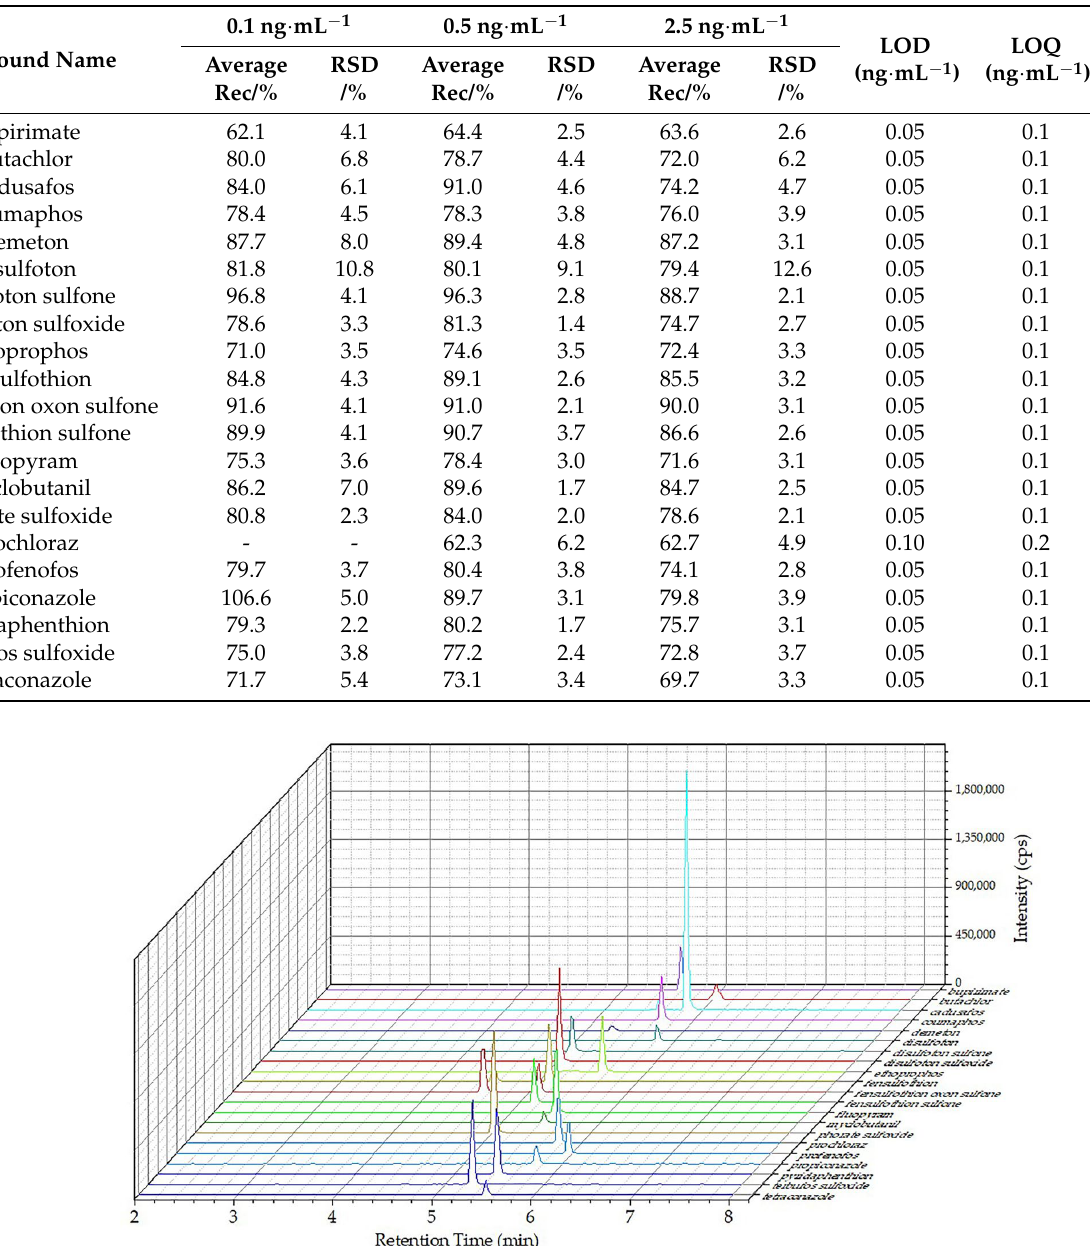
Figure 5. The chromatogram of 21 analytes at fortified level of 0.5 ng·mL − 1 in black tea beverage. Table 2. The method performance of 21 targets in D-μSPE process.